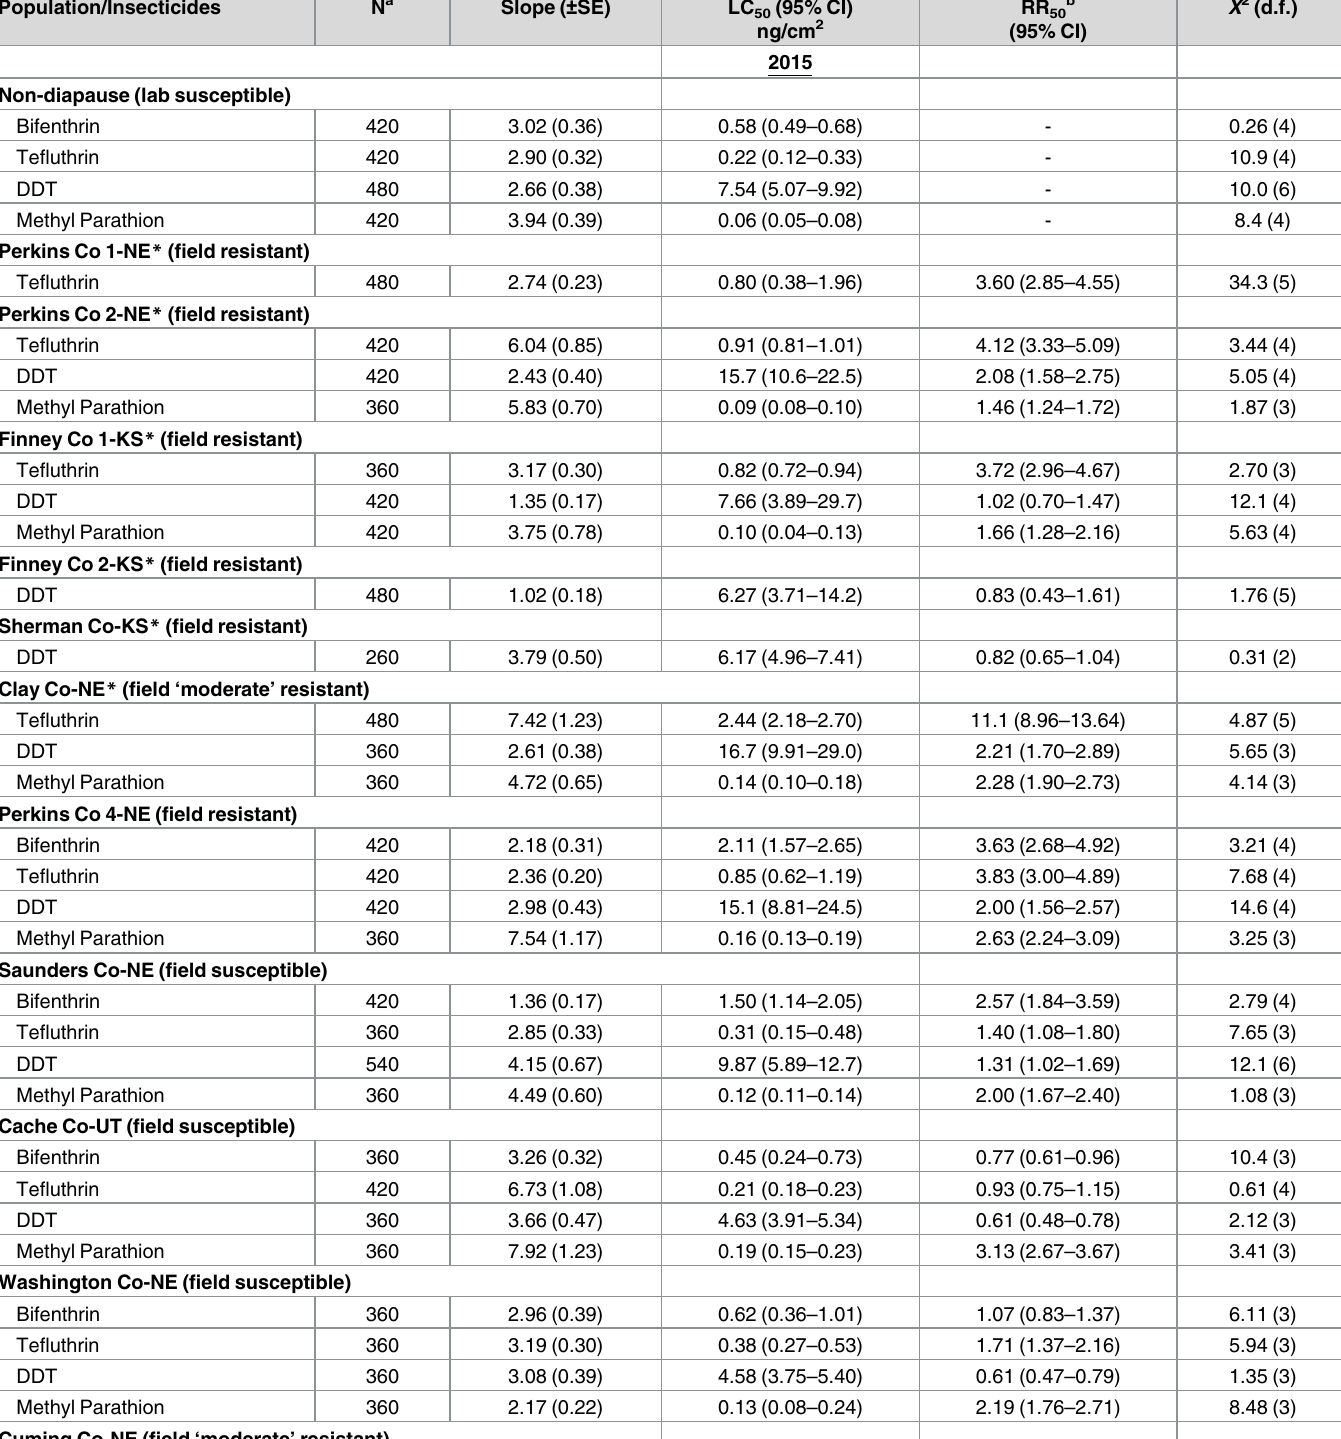
Table 4. WCR larval susceptibility and RRs of field and non-diapause laboratory populations to the insecticides bifenthrin, tefluthrin, DDT, and methyl parathion. Diapauseeggs were collectedfrom field populations in 2014 and 2015 (Keith populations) and bioassaysperformed in 2015 and 2016 (Keith